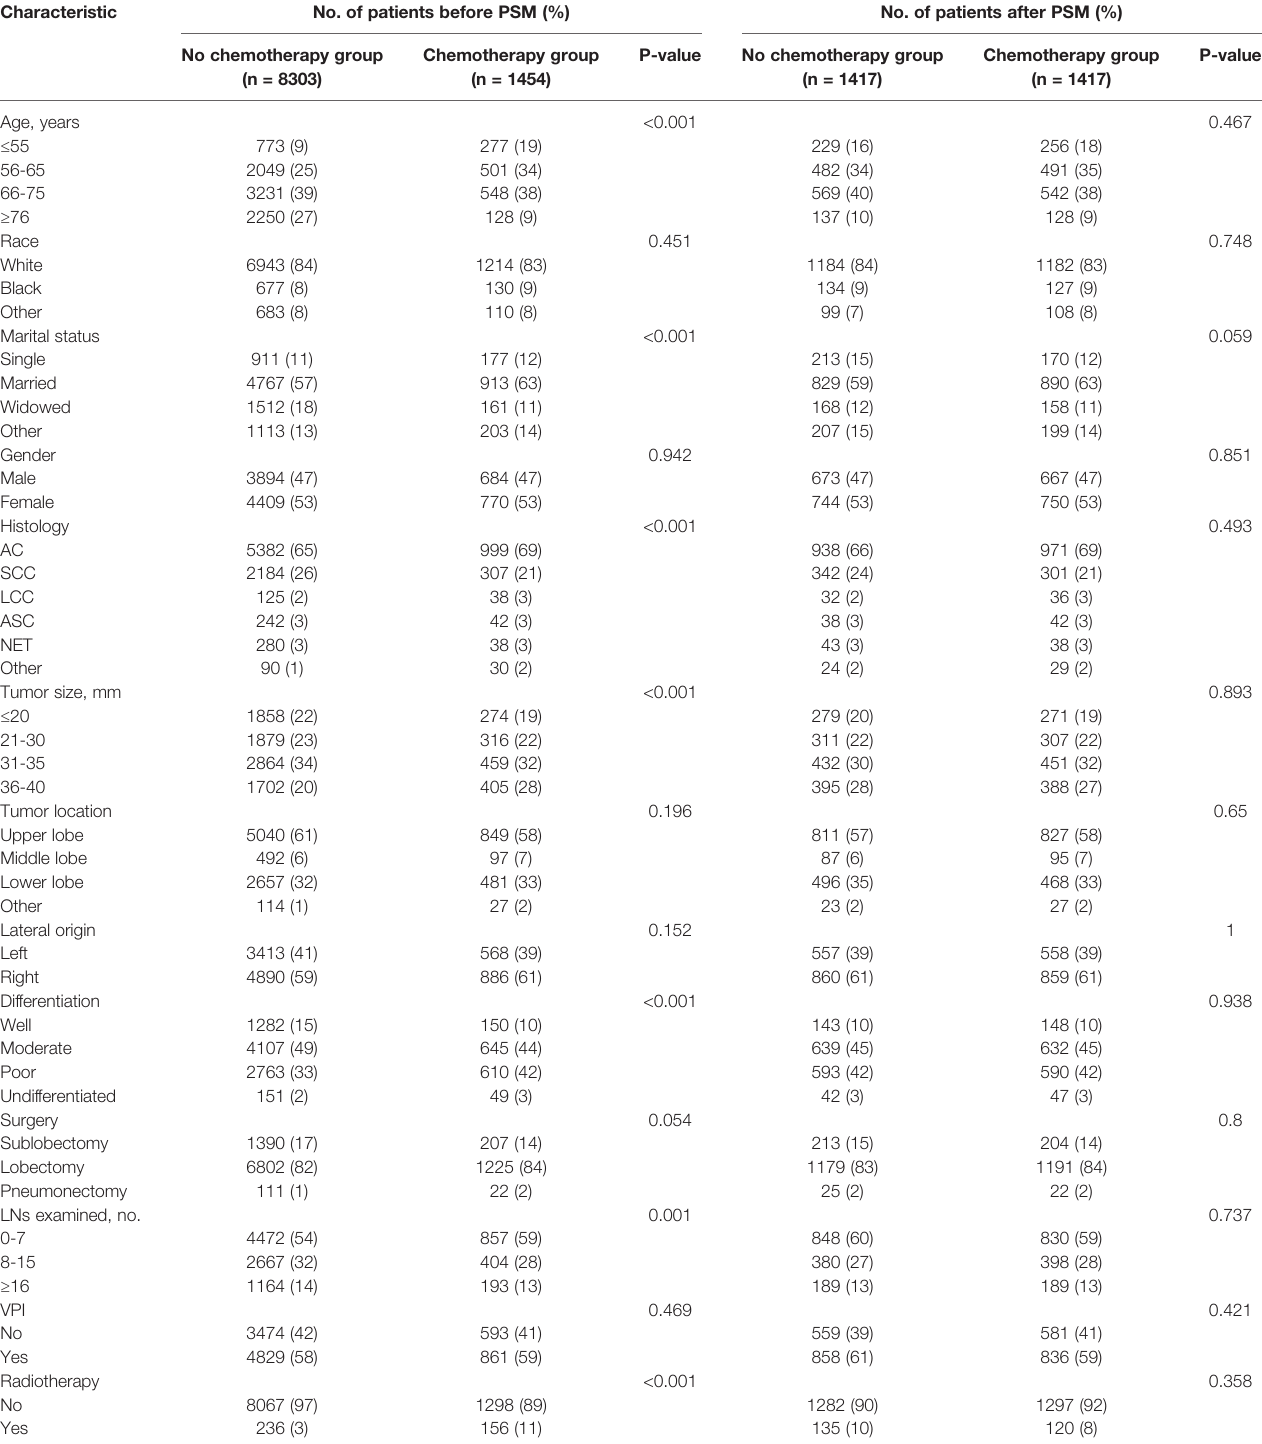
TABLE 1 | Baseline characteristics of stage IB NSCLC patients in the SEER database cohort.